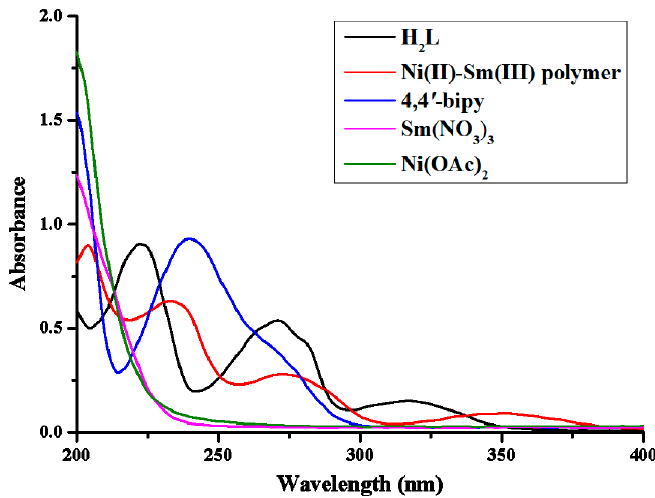
Figure 10. The UV / Vis absorption spectra of H 2 L, its Ni(II)-Sm(III) coordination polymer, Figure 10. The UV/Vis absorption spectra of H 2 L, its Ni(II)-Sm(III) coordination polymer, Ni(OAc) 2 ⋅ 4H 2 O, Ni(OAc) 2 · 4H 2 O, Sm(NO 3 ) 3 · 6H 2 O, and 4,4 (cid:48) Sm(NO 3 ) 3 ⋅ 6H 2 O, and 4,4 ′ -bipy.